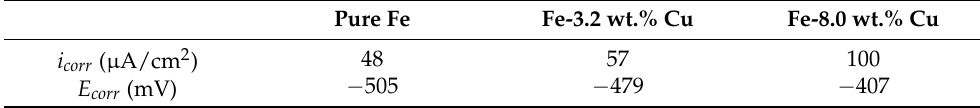
Figure 9. Tafel plots for typical sintered iron and iron-copper samples. Table 2. Corrosion parameters for typical sintered iron and iron-copper samples. Pure Fe Fe-3.2 wt.% Cu Fe-8.0 wt.%